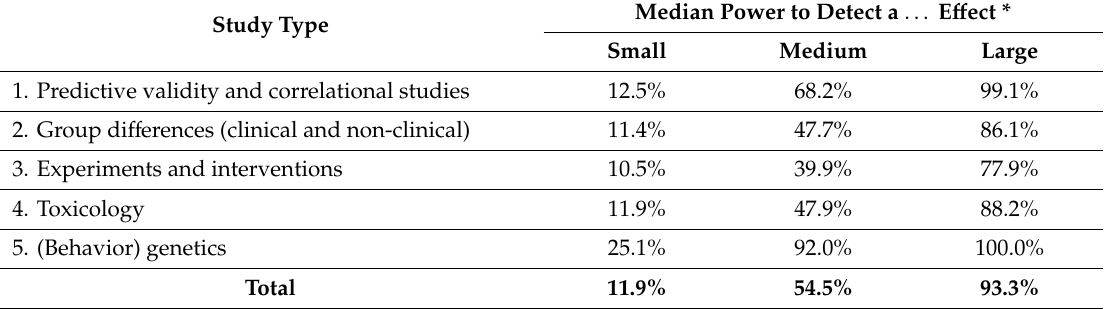
Table 3. Median power of primary studies in intelligence research to detect a small, medium, and large e ff ect, split up per study type and